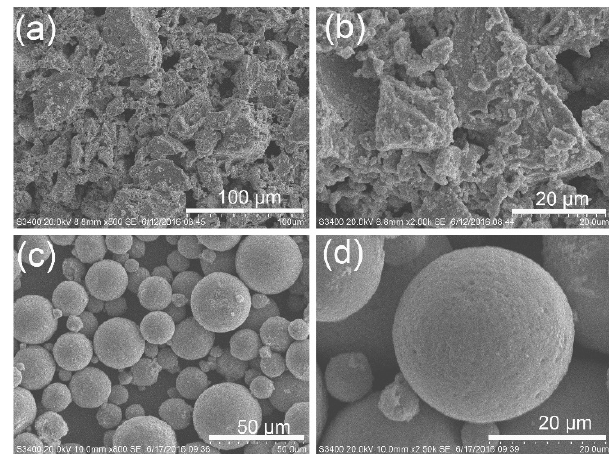
Figure 2. SEM micrographics of ( a , b ) prealloy powders reduced at 973 K and ( c , d ) sphercial Fe 50 Ni 50 alloy powders fabricated at 1823 K.